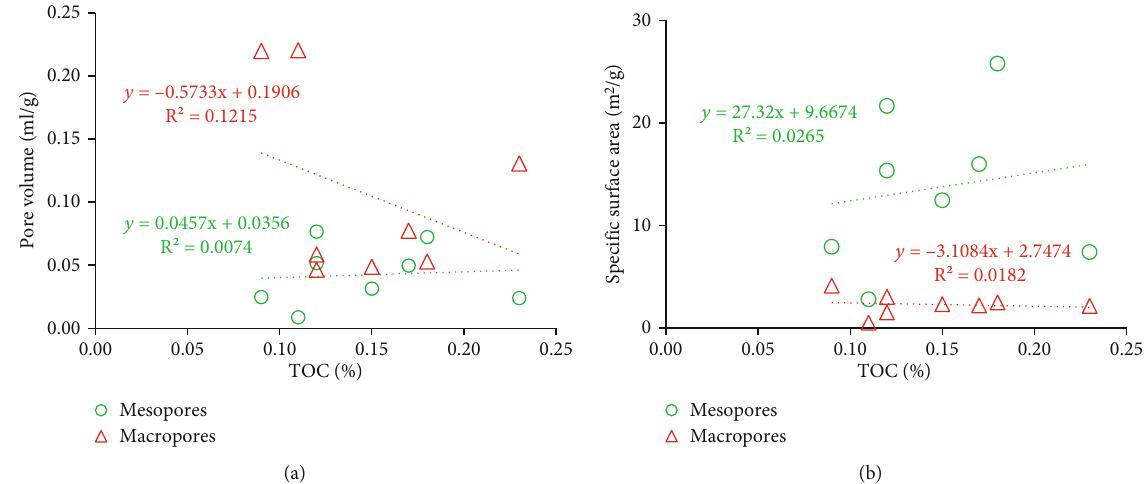
Figure 12: Plots showing the relationship between pore structure and TOC content. (a) Pore volume has a weak correlation with TOC; (b) no obvious correlation between speci fi c surface area and